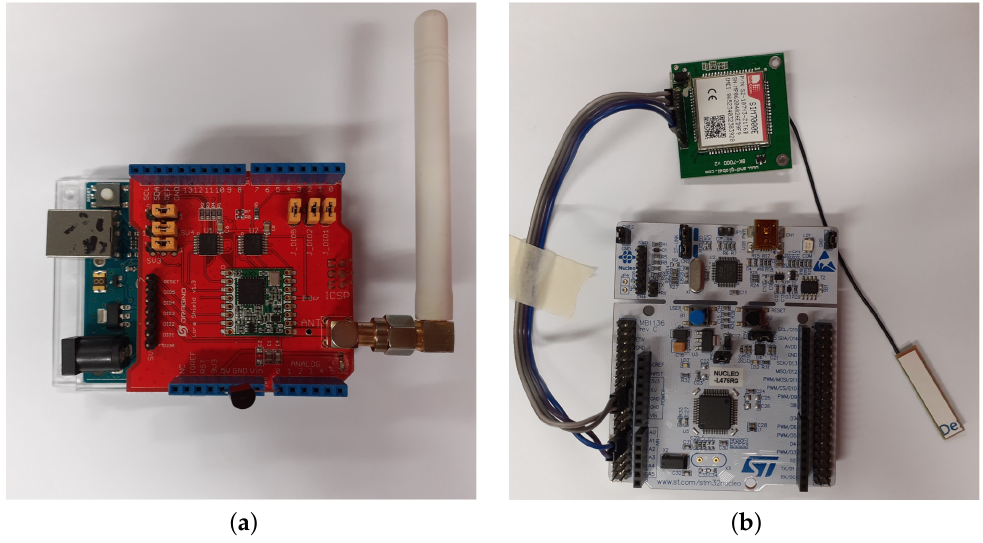
Figure 3. Sensor node hardware implementation: ( a ) LoRaWAN Node; ( b ) NB-IoT Node. LoRaWAN Nodes were composed of an Arduino UNO board and a LoRa